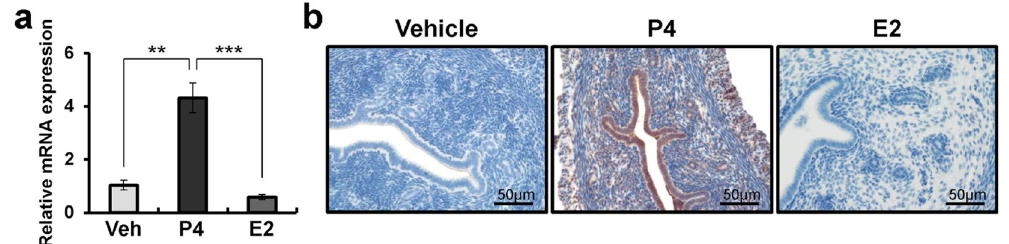
Figure 2. The regulation of Gpr64 by steroid hormones. ( a ) The expression levels of Gpr64 from vehicle, progesterone (P4), or estrogen (E2) treated uteri by quantitative real-time PCR. Total RNA used for the real- time PCR assays was prepared from ovariectomized wild-type C57BL/6 mice treated with vehicle, P4, or E2 for 6 hours. The results represent the mean ± SEM of three independent RNA sets. * p < 0.5 and ** p < 0.01. ( b ) The immunohistochemistry analysis of GPR64 in mice uteri treated with vehicle, P4, or E2 for 6 hours. Nuclei were counterstained with hematoxylin.